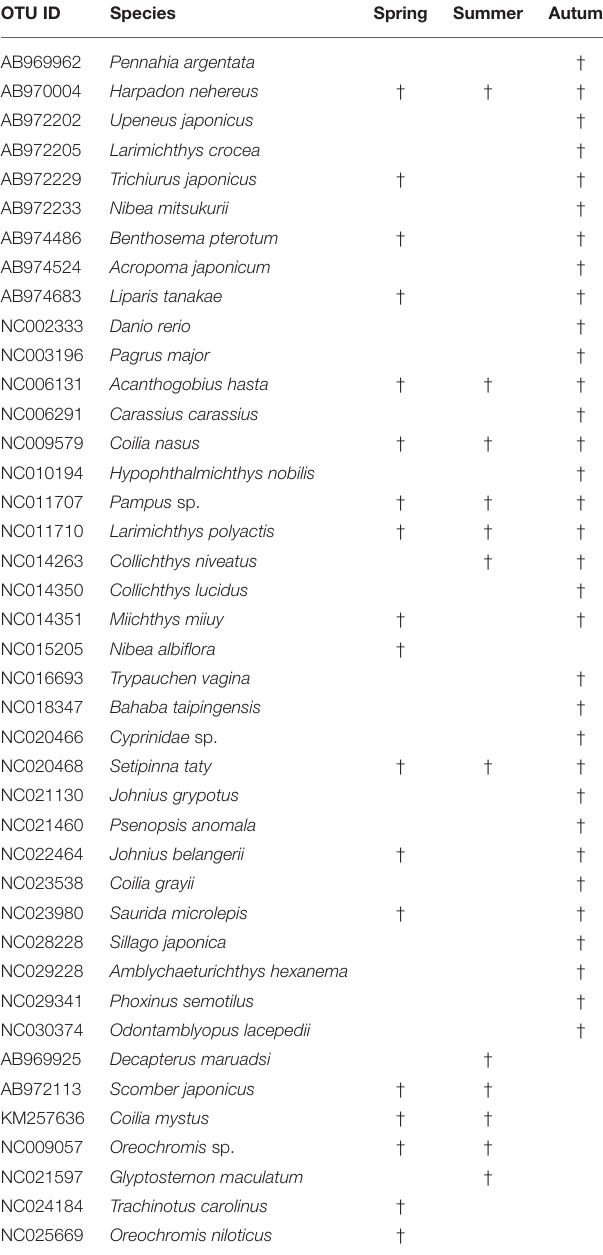
TABLE 2 | OTUs and species information for three